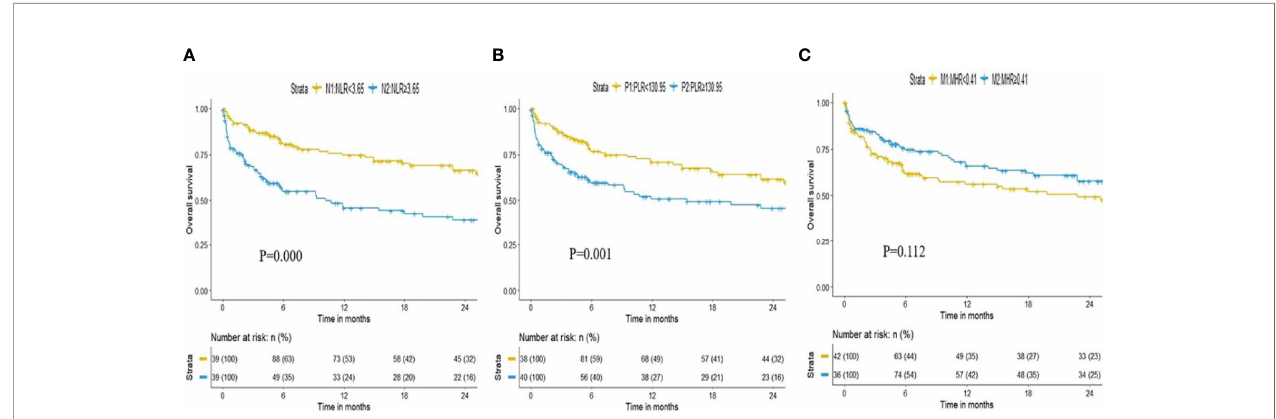
FIGURE 2 | Kaplan – Meier curves for overall survival time by NLR, PLR and MHR: (A) Kaplan – Meier curves for overall survival time by NLR. (B) Kaplan – Meier curves for overall survival time by PLR; (C) Kaplan – Meier curves for overall survival time by MHR.